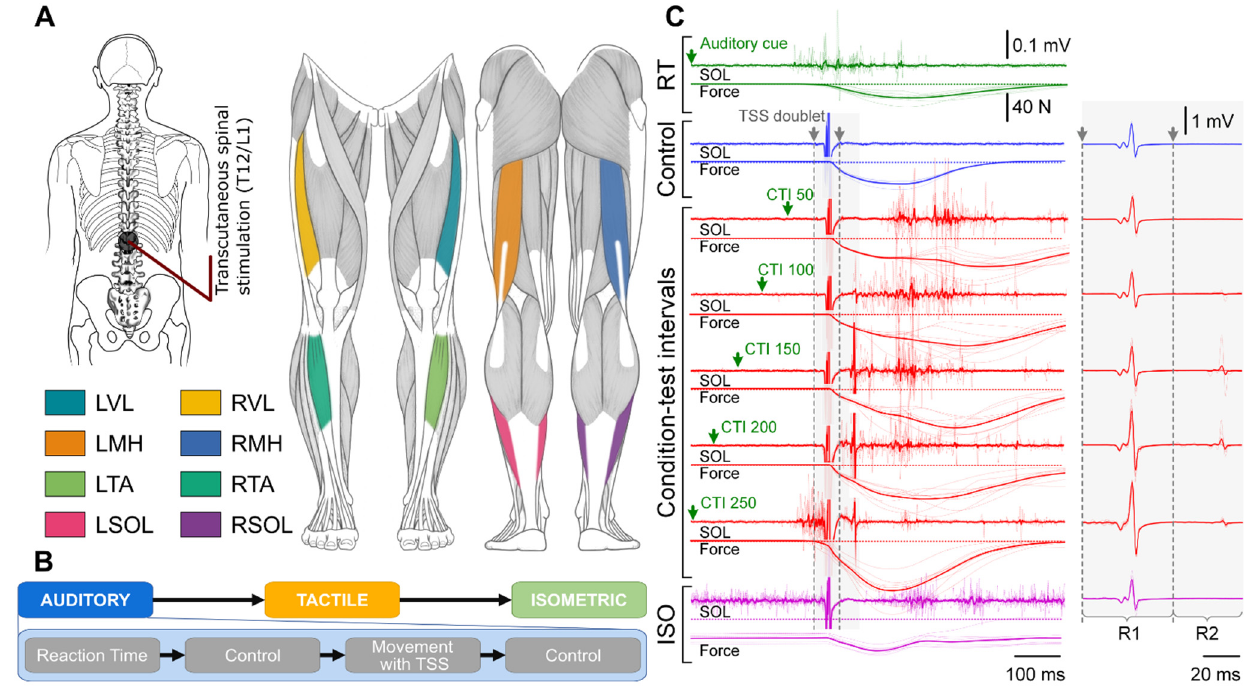
Figure 1. Experimental setup: transcutaneous spinal stimulation ( A ) was applied midline between the T12 and L1 spinous processes. EMG responses were recorded bilaterally from the vastus lateralis (VL), medial hamstring (MH), tibialis anterior (TA), and soleus (SOL) muscles. ( B ) Three experimental conditions were used during each movement task: an auditory cue, a tactile cue, and isometric contraction while TSS doublets were applied. ( C ) All CTIs are shown in red for the left SOL during the plantarflexion task for the auditory condition. Green designates reaction time (RT), blue designates control, and purple designates isometric contraction (ISO). The left and right panels use different time and amplitude scales to better visualize the waveform for voluntary SOL activation during plantarflexion (left panel) and R1 and R2 responses (right panel). Arrows indicate each pulse during the TSS doublets. The dotted horizontal line marks the initial force level prior to movement (left panel). Individual traces are shown with thin lines, and the average response is designated with a bold line.